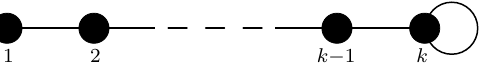
Figure 3 . A simple class of 5d quiver gauge theories with free energy scaling as N 3 . Black nodes represent SU(2 N ) gauge groups, a line connecting two nodes denotes a bifundamental hypermul- tiplet, and the line ending on the same node denotes an adjoint hypermultiplet. No fundamental hypermultiplets are allowed in this